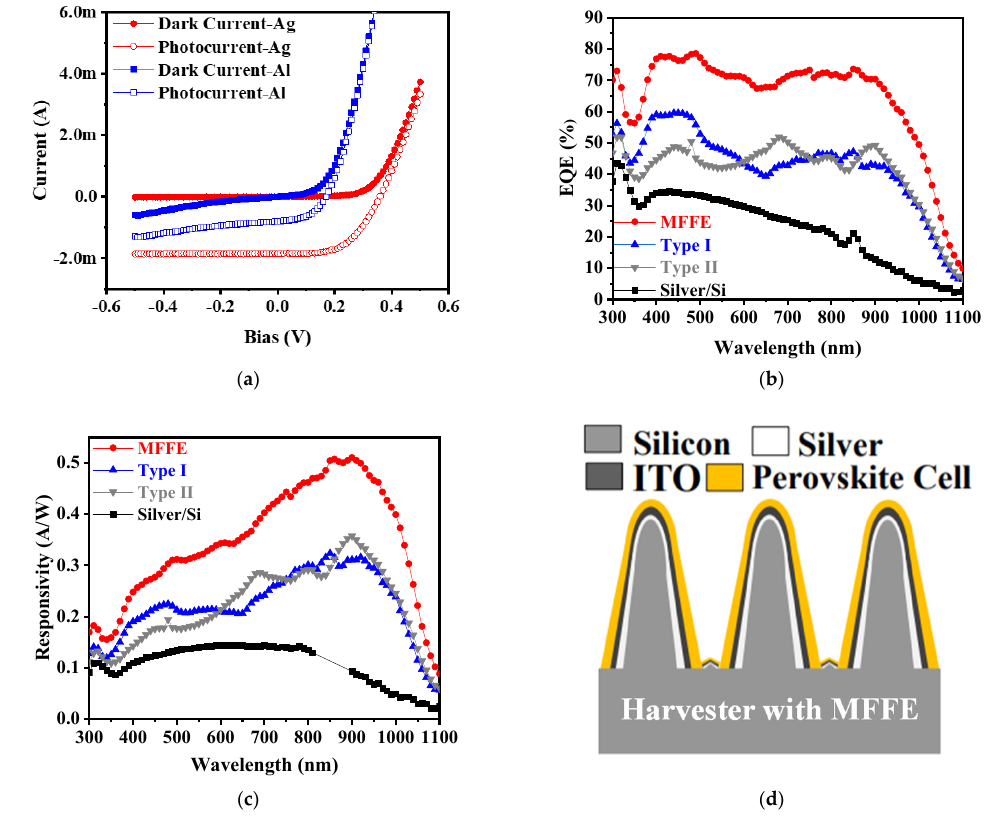
Figure 5. ( a ) Current–voltage (I–V) characteristics of the MFFE device with deposition of different metal materials (Ag and Al); ( b ) the external quantum efficiency (EQE) spectral response; ( c ) the responsivity of the MFFE structure compared to other structures (type I, type II, and silver/si structure); ( d ) concept of integrating a perovskite solar cell with a prepared solar harvester with MFFE. Table 1. Comparisons of device performances.